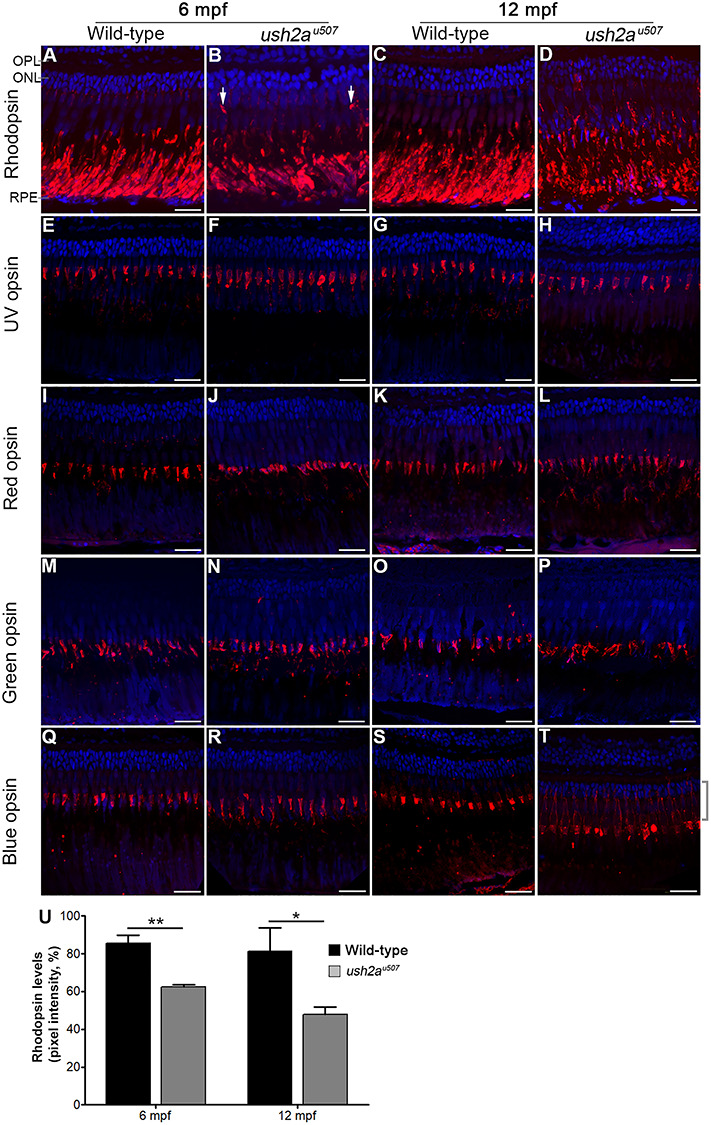
Rod and cone opsin localization in the ush2au507 retina. Rhodopsin (A–D) and UV (E–H), red (I–L), green (M–P) and blue (Q–T) cone opsins were detected in the wt and ush2au507 zebrafish retina at 6 months post fertilization (mpf), and 12 mpf by immunohistochemical analysis (red). In the 6 mpf ush2au507 retina, rhodopsin was partially mislocalized in some regions where it was detected in parts of the rod photoreceptors other than the outer segment (arrows in B). In the 12 mpf mutant retina, rhodopsin was more extensively mislocalized and expression in the rod outer segments was reduced compared to wt. Blue opsin was noted in the blue cone inner segments (highlighted with a bracket) in the ush2au507 retina at 12 mpf (T). All sections are counterstained with DAPI nuclei acid stain (blue). Bar chart (U) shows levels of rhodopsin detected in the rod outer segments at 6 and 12 mpf, measured using pixel intensity on confocal images (mean ± SEM. Three sections analyzed per fish, n = 3 per age). Unpaired t-tests were used to compare wt and ush2au507 rhodopsin levels at each age. *P < 0.05, **P < 0.01. OPL, outer plexiform layer; ONL, outer nuclear layer; RPE, retinal pigment epithelium. Scale bar = 25 μm.